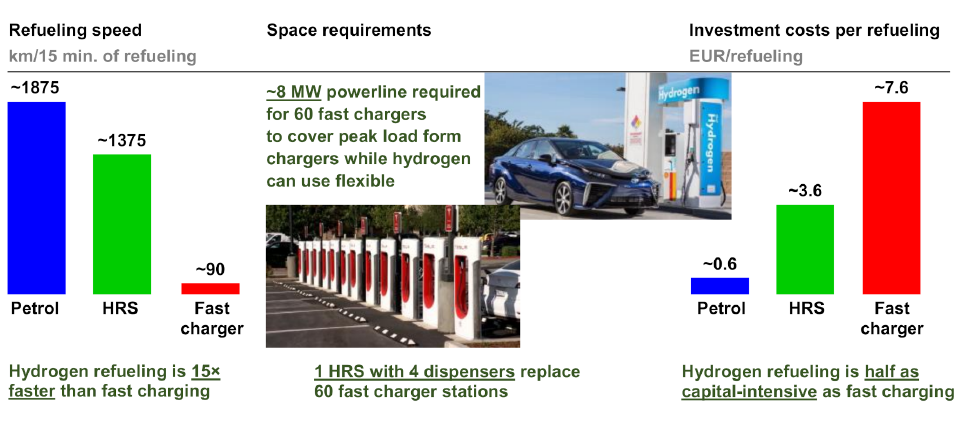
Figure 2. Comparison of refueling performance and investment rates for traditional and near-future fuels